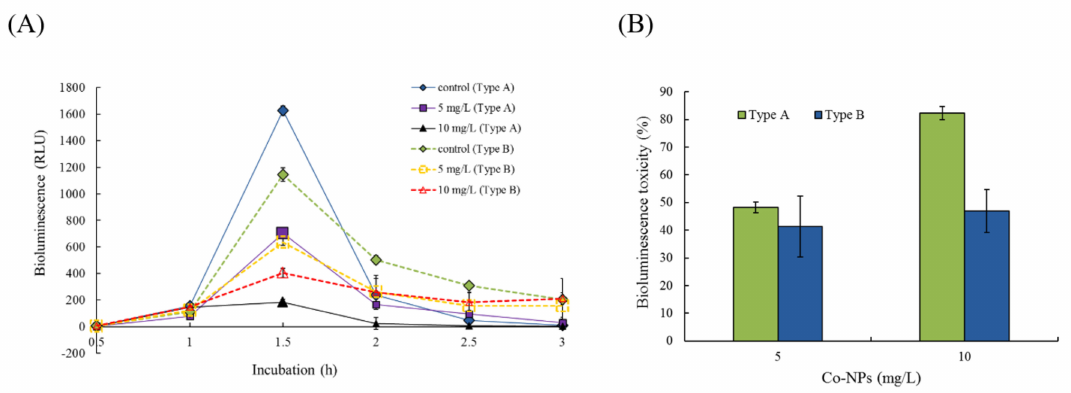
Figure5. Dose–response(percentageofrelativebioluminescence)curvesofthee ff ectsofthetwodi ff erent sizes of Co-NPs on the bioluminescence activities of RB1436 during the incubation period: ( A ) relative activity changes during incubation periods, ( B ) comparisons of the toxicity based on the average of two measurements (1.0 and 1.5 h). Values are given as the mean ± SD (standard deviation) of triplicate samples.